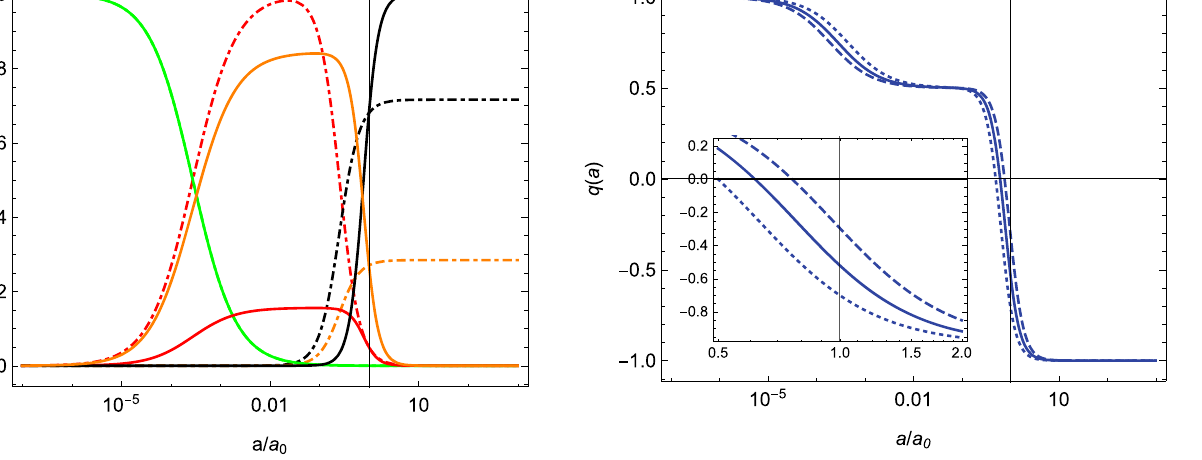
Fig. 3 An comparison of the calculated cosmic evolutions of the den- sity parameters of dark energy between the two models. The results of the standard (cid:2) CDM model are shown in solid curves, and those of the generalized Rastall theory are indicated by dash-dotted curves are shown in Figs. 1, 2, 3, 4 and 5 by the solid curves in different colors.